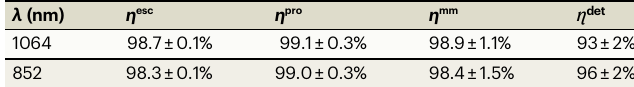
Table 2 | Estimated ef fi